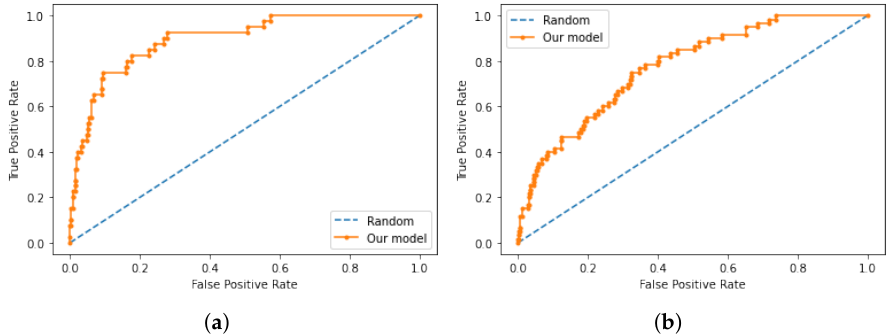
Figure 2. ROC curves for the model presented in the article for the validation dataset. ( a ) 24 h forecasting, ( b ) 48 h forecasting.